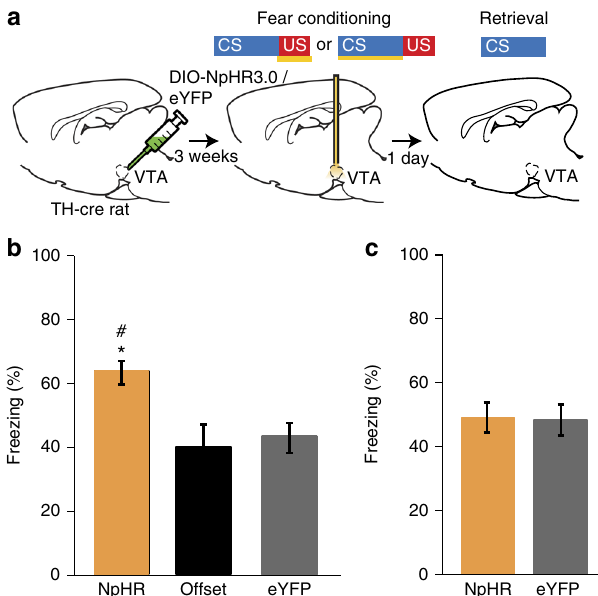
Fig. 2 Optogenetic inhibition of VTA-dopamine neurons during shock period of fear conditioning enhances learning. a Experimental paradigm for optogenetic inactivation of VTA-dopamine neurons during shock or auditory CS period of fear conditioning. Brain image adapted from ref. 70